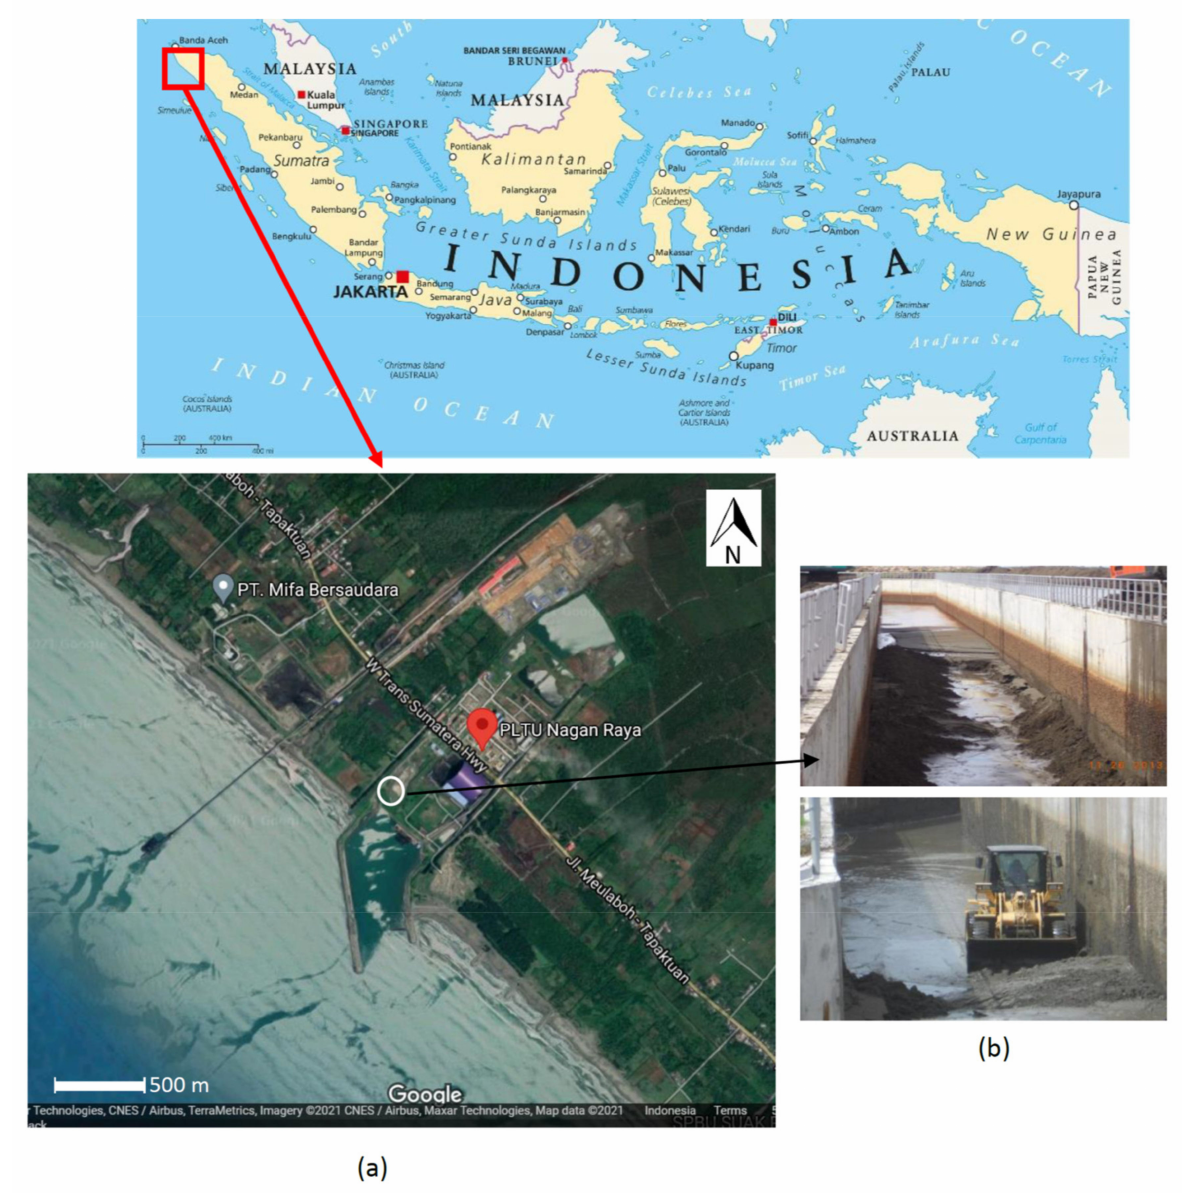
Figure 1. ( a ) Location of Nagan Raya Power Plant [18] ( b ) Sedimentation in water-intake